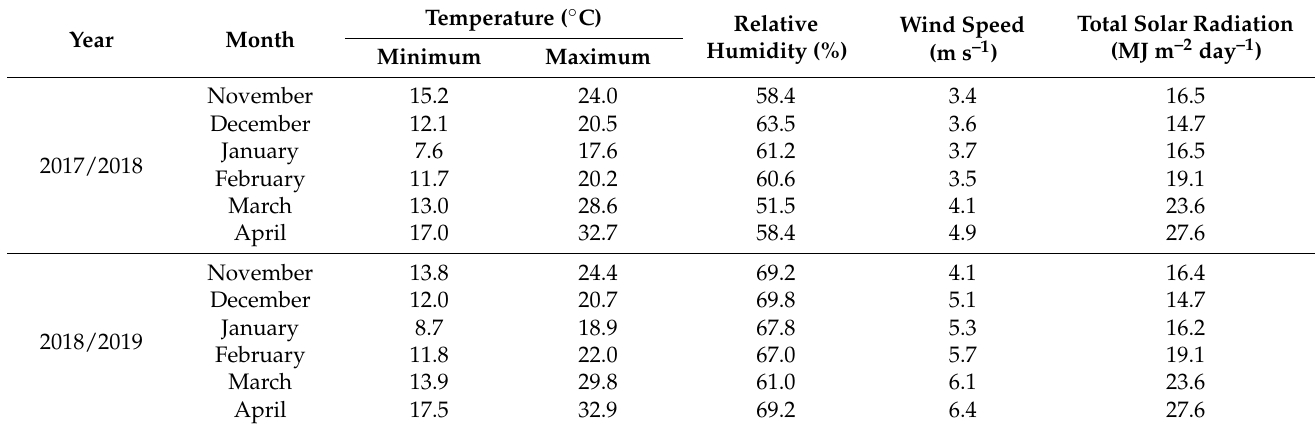
Table 1. Monthly agro-climatological data at Sadat City during the two growing